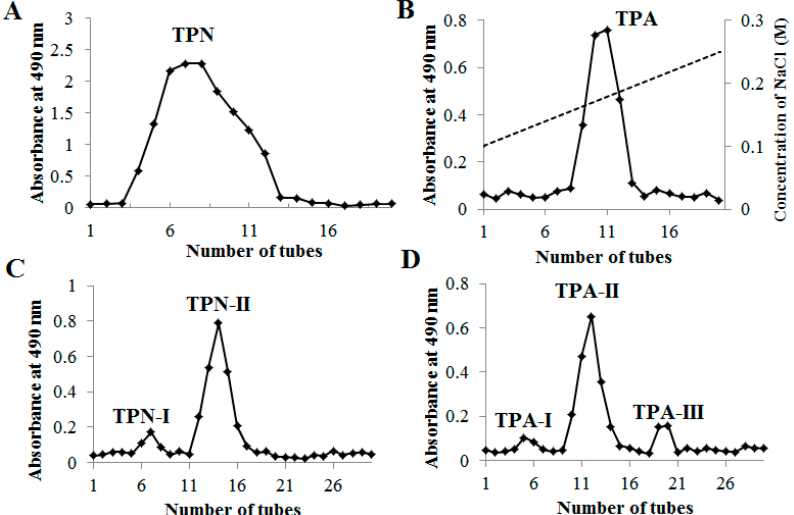
Figure 2. Elution curve of neutral fraction of total polysaccharides (TPN) ( A ) and acidic fraction of total polysaccharides (TPA) ( B ) on diethylaminoethyl cellulose 52 (DEAE-52) column, and elution curves of TPN-II ( C ) and TPA-II ( D ) on Sephadex-G50 and Sephacryl S-300 column, respectively.